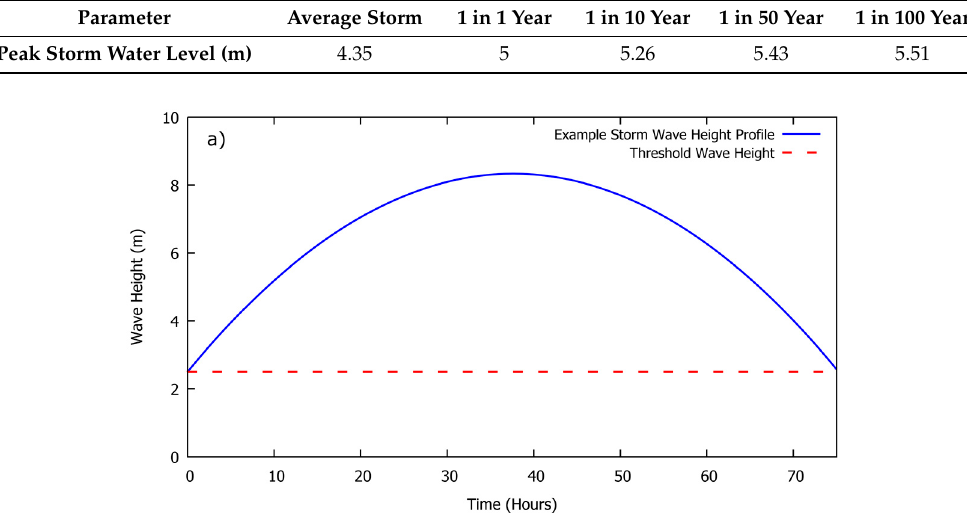
Table 2. Peak storm water levels in Carmarthen Bay, determined following McMillan et al.